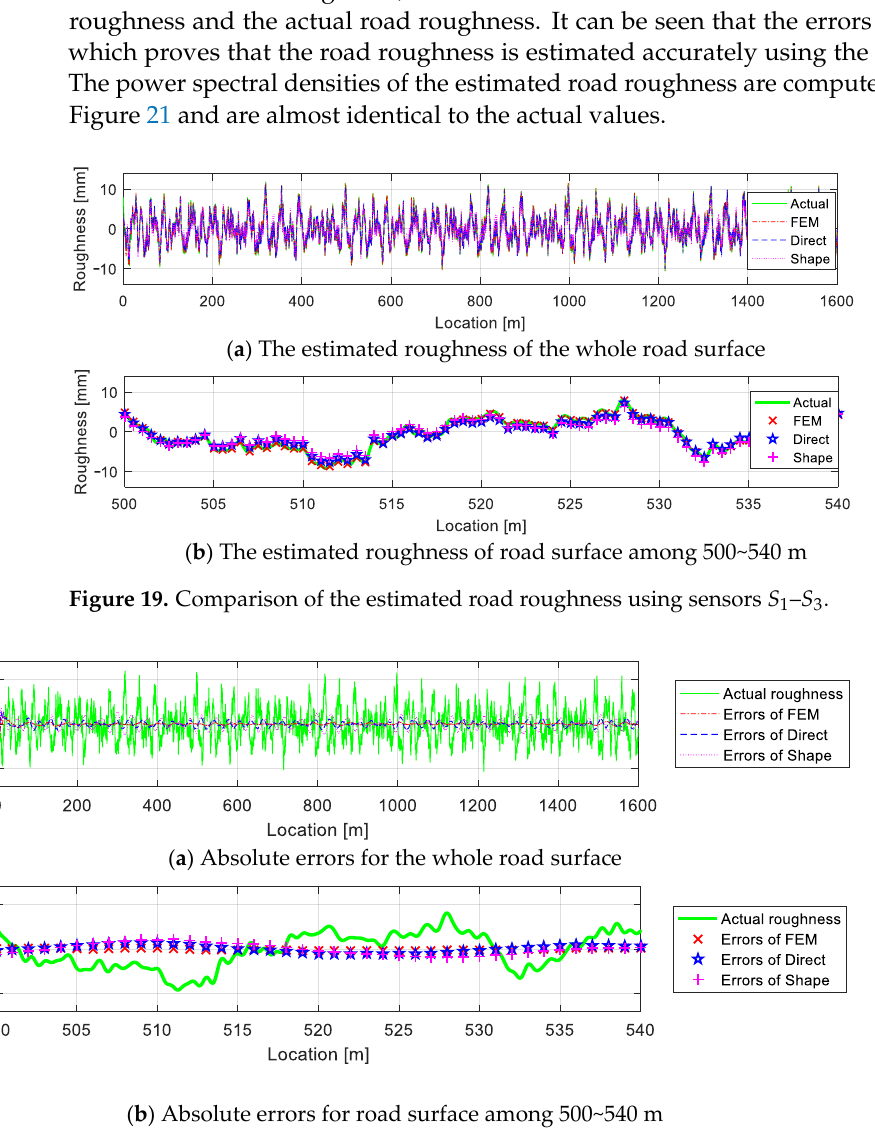
Figure 20. Absolute errors of the estimated road roughness for Case A using sensors S 1 – S 3 .